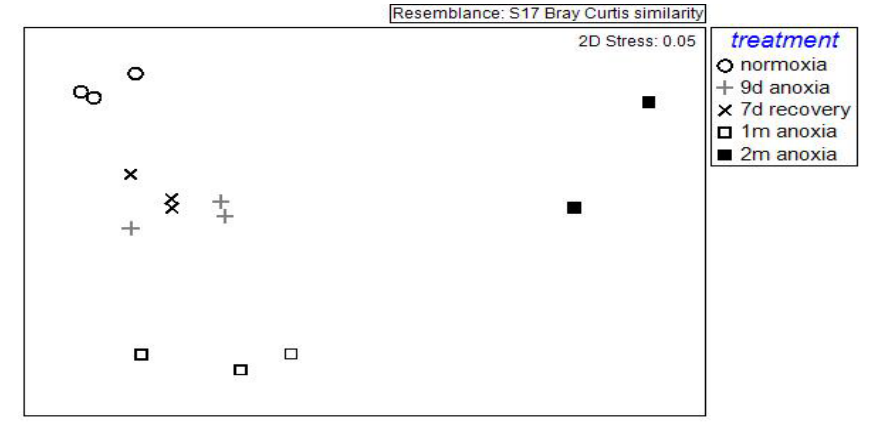
Fig. 2. MDS based on absolute harpacticoid copepod composition (depth pooled, without